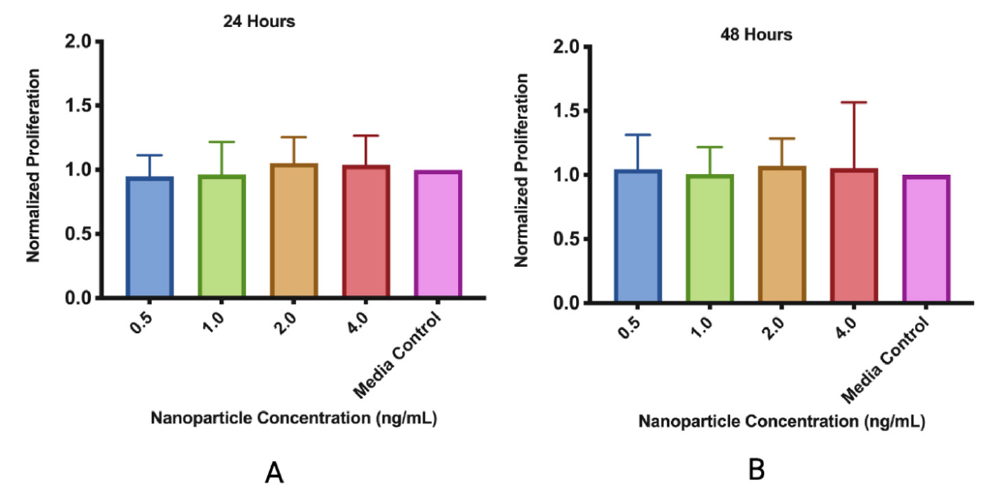
Figure 7. MMSC ECM nanoparticles are biocompatible. ( A ) MMSC ECM nanoparticles were added with MMSCs for 24 h to test proliferative effects. ( B ) MMSC ECM nanoparticles were added to MMSCs for 48 h to test cytotoxicity. The data displayed are the mean ± standard deviation. N = 3.